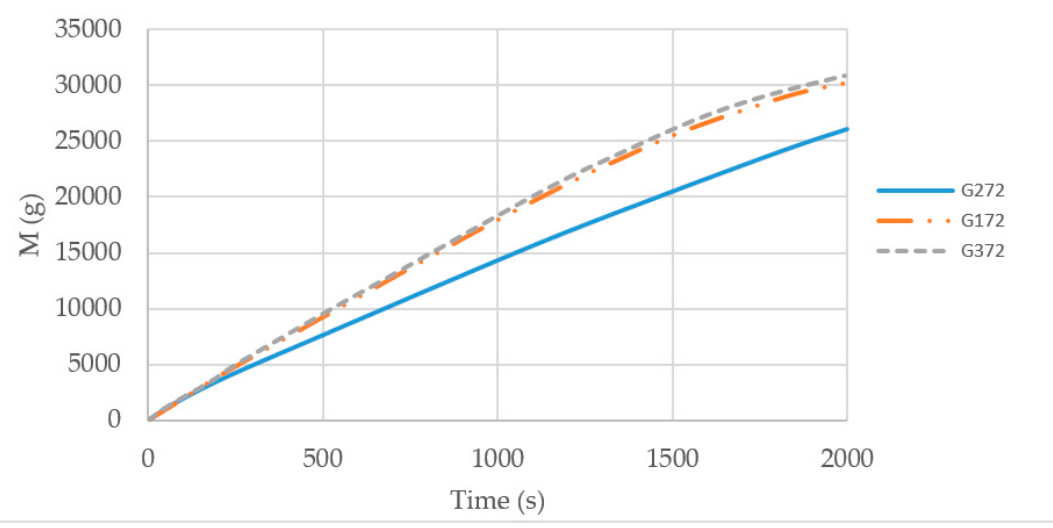
Figure 4. Amount of deposition in the three reservoirs over 2000 s.